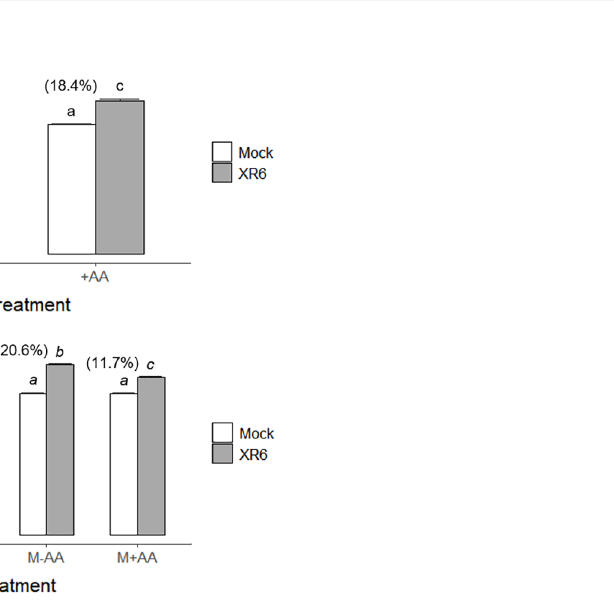
FIGURE 10 Changes in ROS levels and growth rates of C. reinhardtii cells by treatment of ascorbic acid (AA) following X-irradiation with 6 Gy. XR6 represents X-rays of 6 Gy. (A) The ROS level was calculated relative to the mock without AA treatment by the DCF signal at excitation 480 nm and emission 530 nm as described in the Materials and Methods section. (B) Cell density (OD 750 ) of C. reinhardtii 2 days after the second repetitive X-irradiation. Cells were incubated without or with 1 mM AA for 1 h at 25°C after X-irradiation, and were subjected to heterotrophic (H) cultivation in darkness or mixotrophic (M) cultivation under light for 2 days. Data represent the mean ± standard error (SE) with n = 6 from two independent experiments. Different letters indicate signi fi cant differences at p < 0.05 (one-way analysis of variance followed by Tukey ’ s honestly signi fi cant difference test). Digits in parentheses are percent differences in average between mock and irradiated